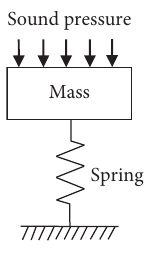
Figure 5: Spring-mass model of Helmholtz